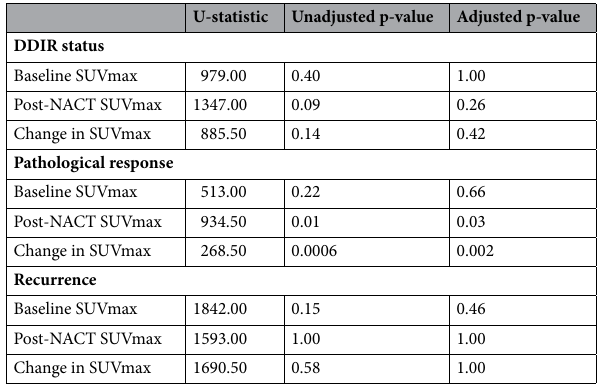
Table 2. Association of PET metrics with DDIR status, pathological response and recurrence.